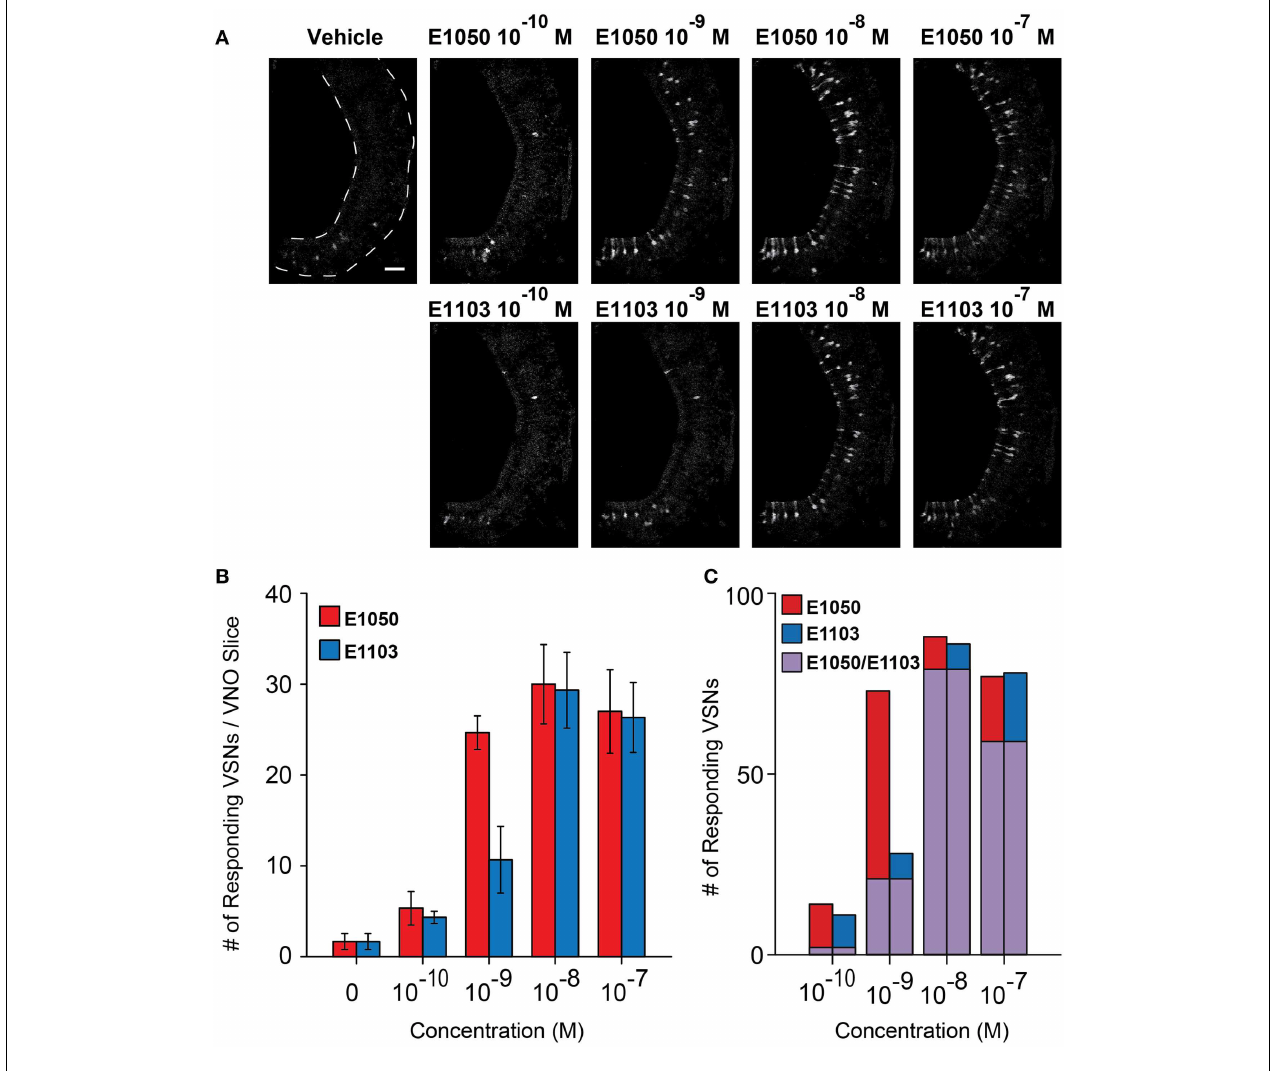
FIGURE 1 | Activation of VSN by E1050 and E1103. (A) Representative imaging experiments showing the VSN responses to E1050 (top) and E1103 (bottom). Scale bar, 50 µ m. (B) Bar graph showing the number of VSNs activated by E1050 (red) and E1103 per